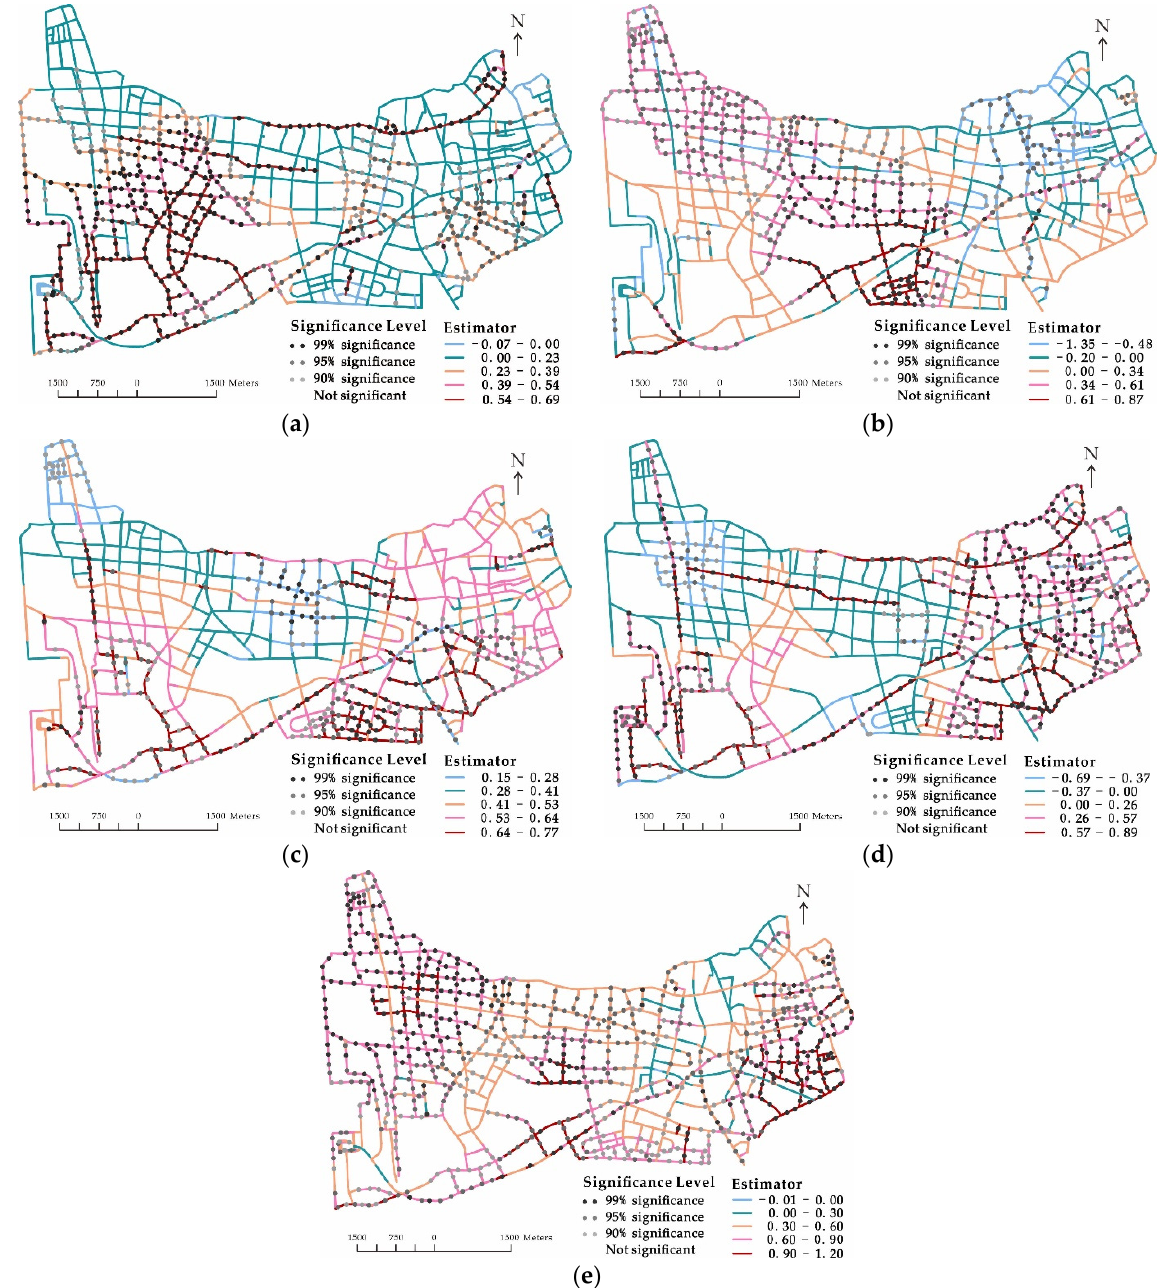
Figure 4. Spatial distribution of coefficient estimations and significance levels of by community variable. ( a ) num_nursing,